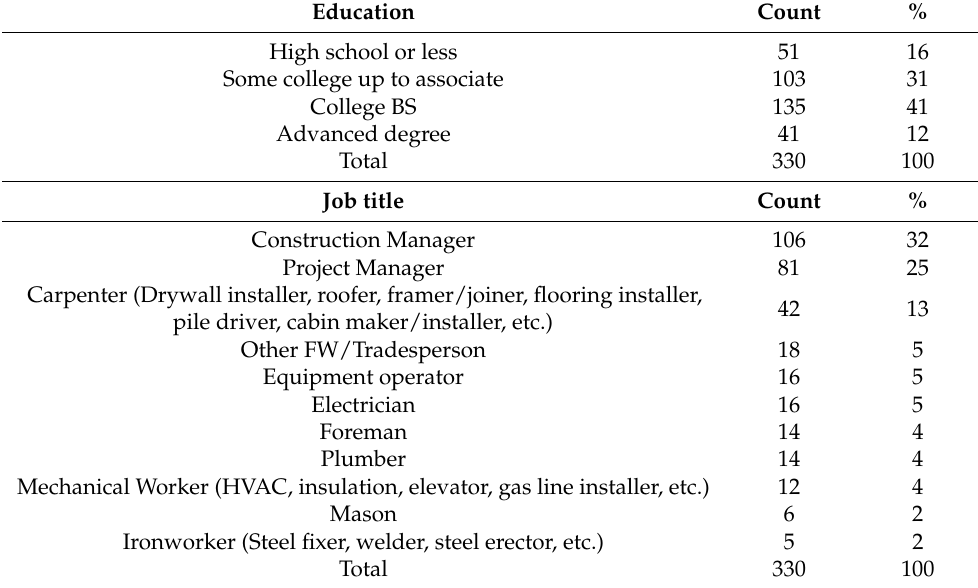
Table 2. Demographic Information.